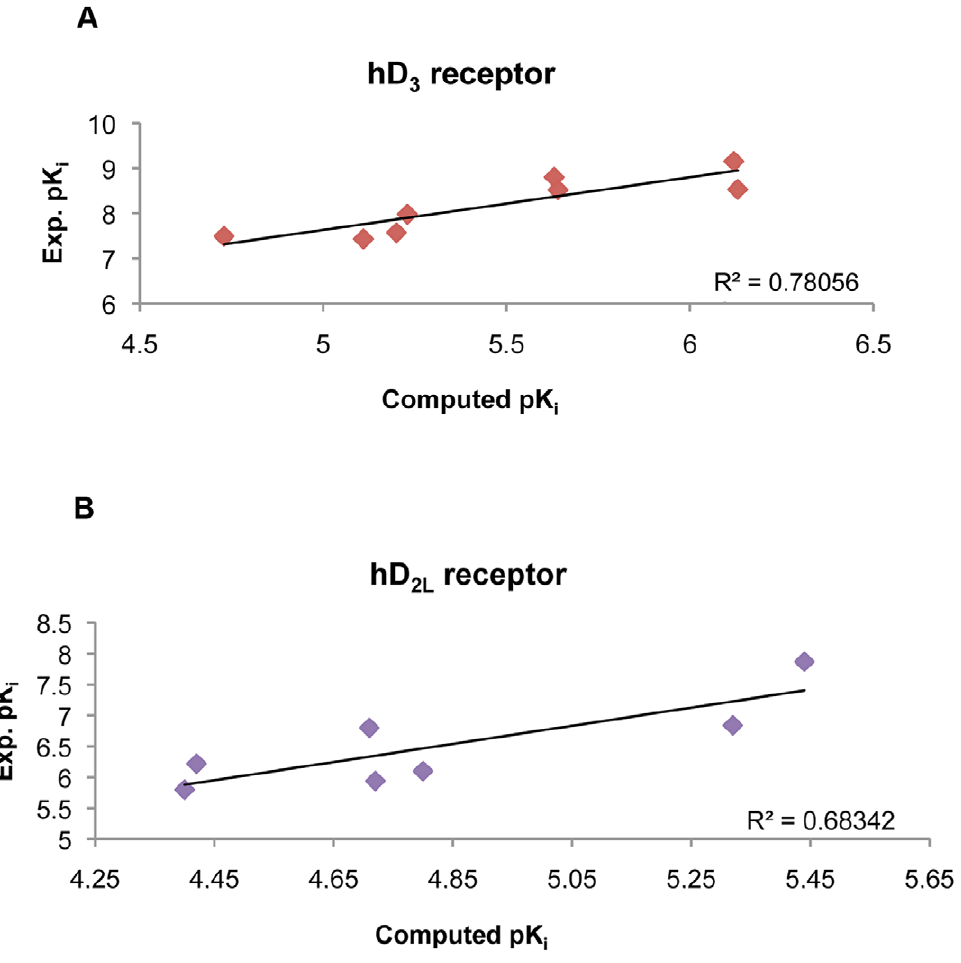
Figure 7. Correlation of predicted pK i and experimental pK i values. Plots of D 3 preferring agonists docked toward hD 3 (A) and hD 2L (B) receptors: a. dopamine; b. 7-OH-DPAT; c. 7-OH-PIPAT; d. pramipexole; e. quinpirole; f. ropinirole; g. rotigotine; h. PD 128,907; i. cis-8-OH-PBZI; j. ZINC45254546.